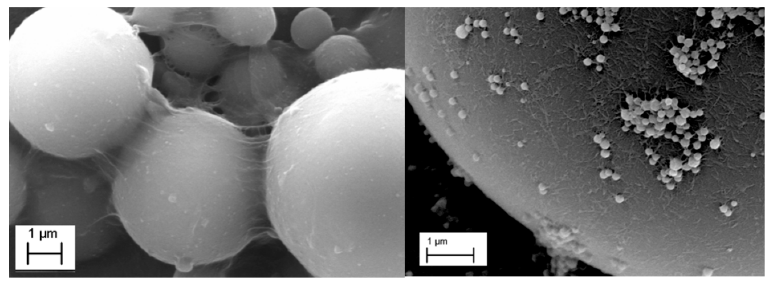
Figure 10. Polymerized styrene beads stabilized with SF-CNFs ( Left ) and REF-CNCs ( Right ) using a 0.2 wt.-% nanoparticle